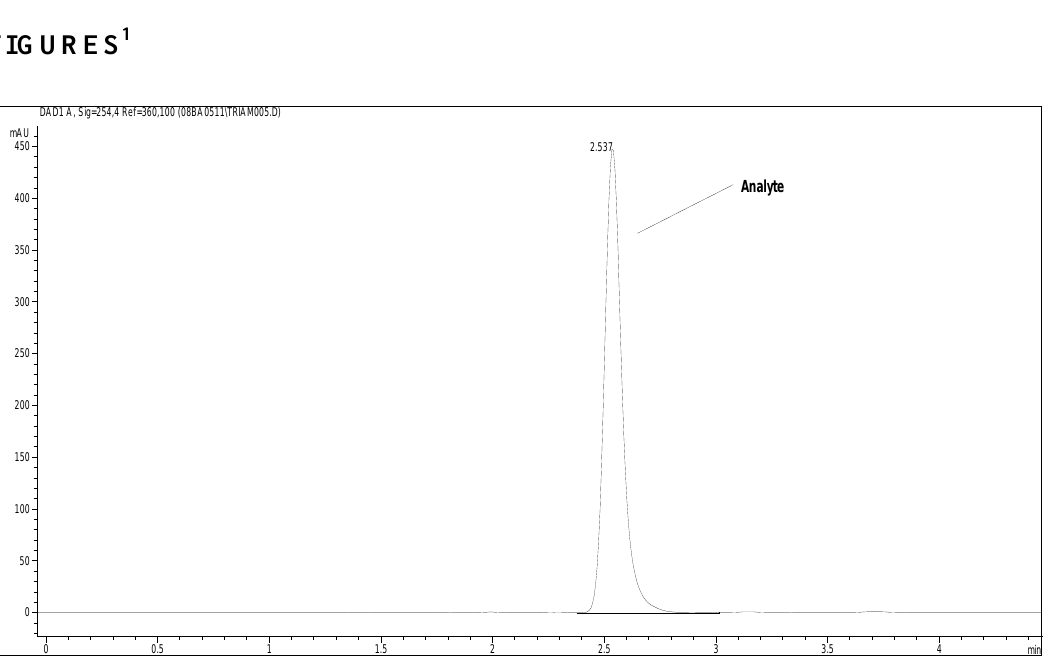
Figure 1. An example chromatogram of a nonstability-indicating HPLC method that evaluates the potency of a single